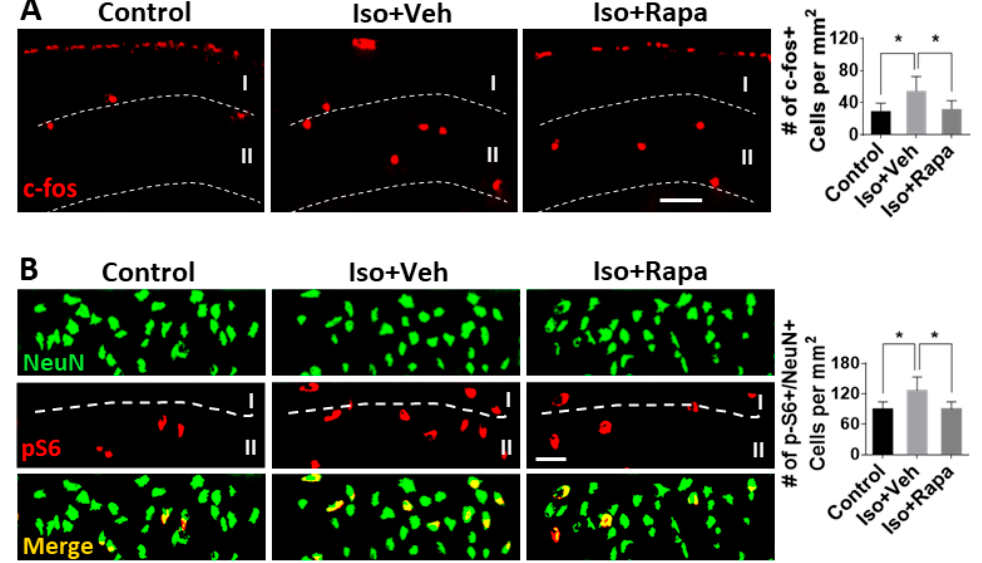
Figure 4. Neuronal activity and pS6 expression in superficial spinal dorsal horn (SDH; lamina I + II). ( A ) Isoflurane exposure upregulated the c-fos-positive neurons and rapamycin treatment restored this number near the control. Bar = 50 µ m. Graph showed quantitative results. ( B ) The number of pS6- positive/NeuN-positive neurons in lamina I + II of isoflurane-exposed mice was greater than the control, and was attenuated with rapamycin treatment. Bar = 50 μ m. One-way ANOVA for both ( A )